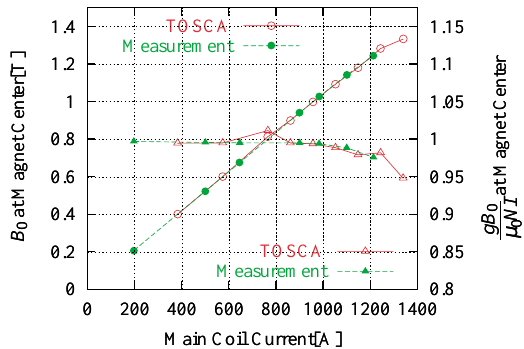
FIG. 12. (Color) Excitation curve of measured and calculated magnetic fields. The B 0 is a nominal value of the center of the D sector. The circles show the nominal value B 0 . The triangles show the field strength per excitation power gB 0 (cid:3) m 0 NI .